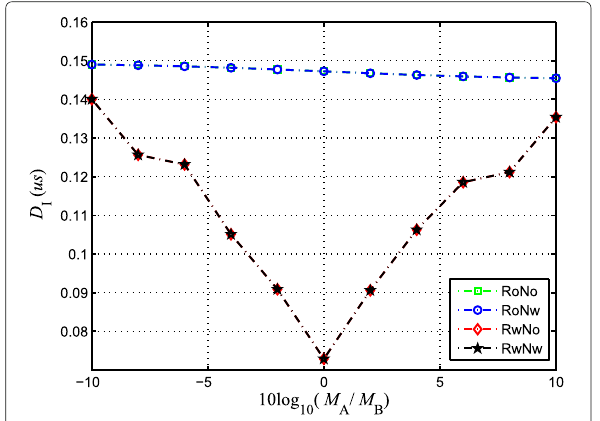
Fig. 7 D I and D II performance comparison of the four schemes in Example 1, where h A = [6 6 5 5 4 3 2 2 1] and h B = [6 6 6 5 4 4 3 2 1